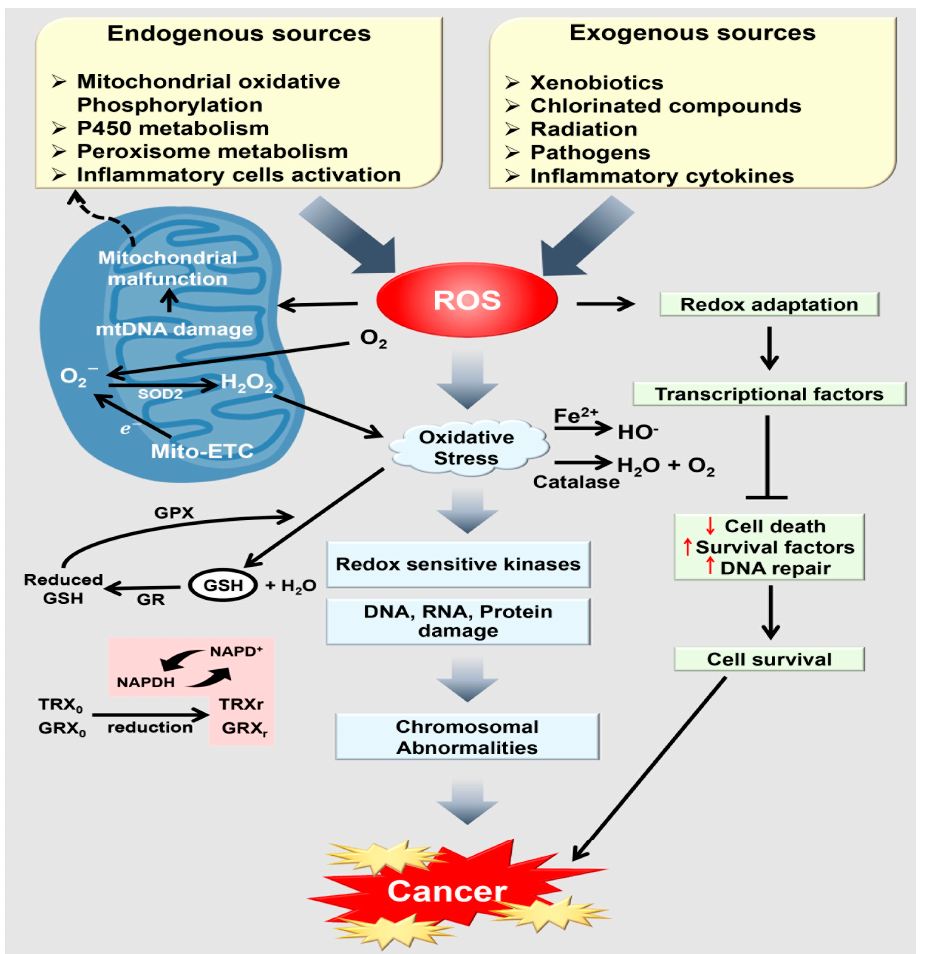
Figure 5. A schematic diagram of overall signaling pathways of cancer progression induced by oxidative stress. SOD: superoxide dismutases; Mito-ETC: mitochondrial electron transport chain, GSH: glutathione; GR: glutathione reductase; GPX: glutathione peroxidase; GRXo, glutaredoxin (oxidized); GRXr: glutaredoxin (reduced); GSHr: glutathione (reduced); TRXo, thioredoxin (oxidized); TRXr: thioredoxin (reduced). Black arrows represent activation and T bar represent inhibition, red colored arrows represent upregulation/downregulation. (Adapted from [273]).